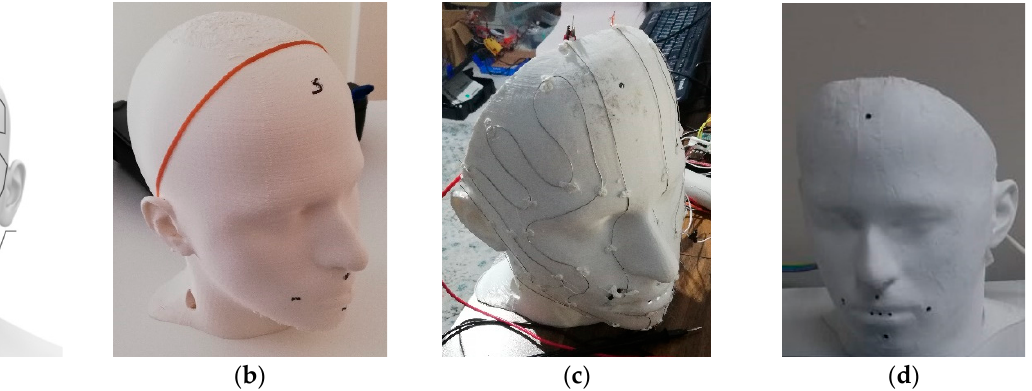
Figure 2. The resistance and sensor application stages on the head model. ( a ) Thermal head resis- tor and sensor layout. ( b ) The state of the 3D print head model before it is processed. ( c ) Laying of the temporary resistance wire on the head model. ( d ) Resistors embedded in the thermal head model and painted.